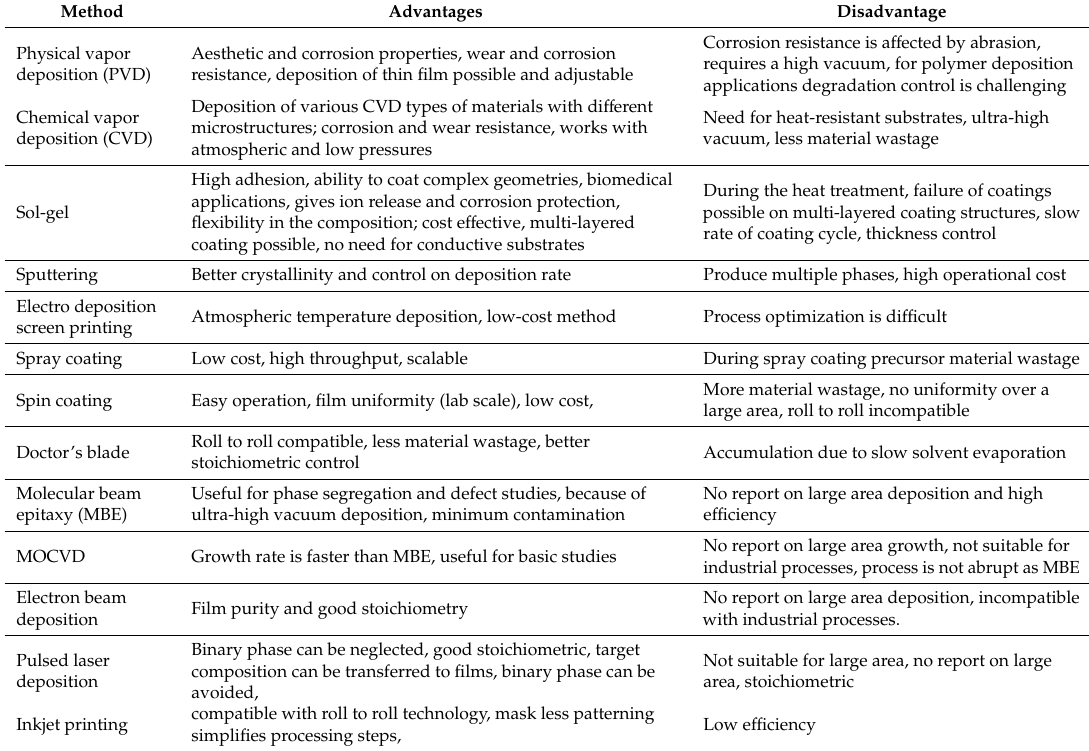
Table 7. Advantages and disadvantages of the di ff erent